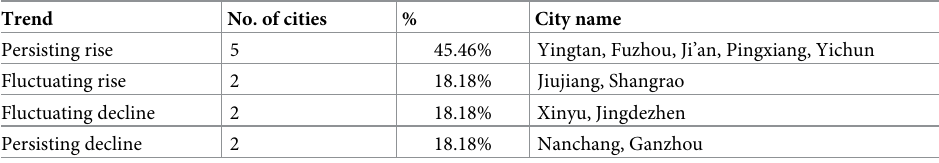
Table 6. Dynamic changes of ecological civilization of cities in Jiangxi Province.